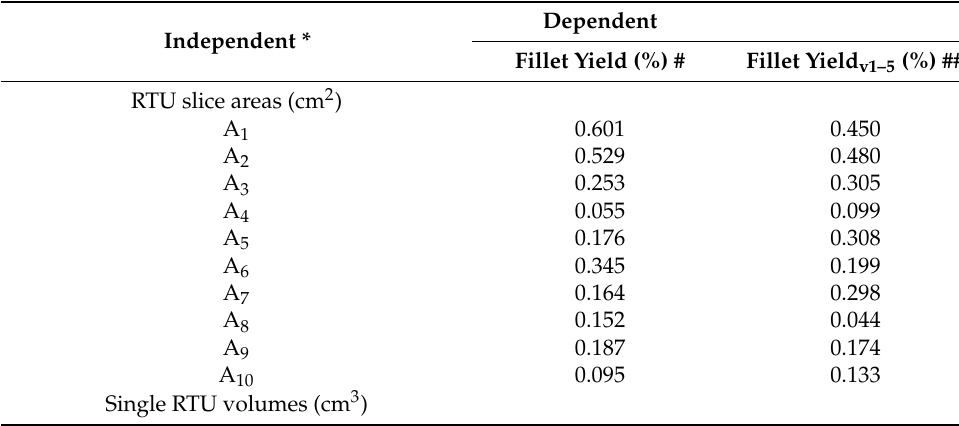
Table 4. Correlations between fillet yields and real-time ultrasonic (RTU) traits (n =